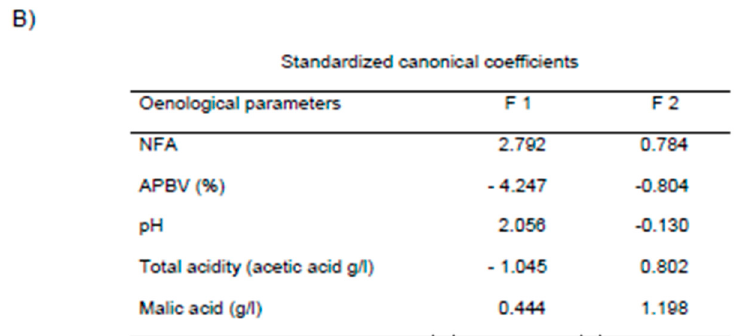
Figure1. ( A )Canonicaldiscriminantanalysisofcontrolinitialmust(1.) ofTempranillo(Temp), Grenache (Gre) and Graciano (Gra). ( B ) Standardized canonical coe ffi cients of the two main discriminant functions Figure 1. ( A ) Canonical discriminant analysis of control initial must (1.) of Tempranillo (Temp), (F1 and F2) obtained for oenological Grenache (Gre) and Graciano (Gra). ( B ) Standardized canonical coefficients of the two main discriminant functions (F1 and F2) obtained for oenological parameters.